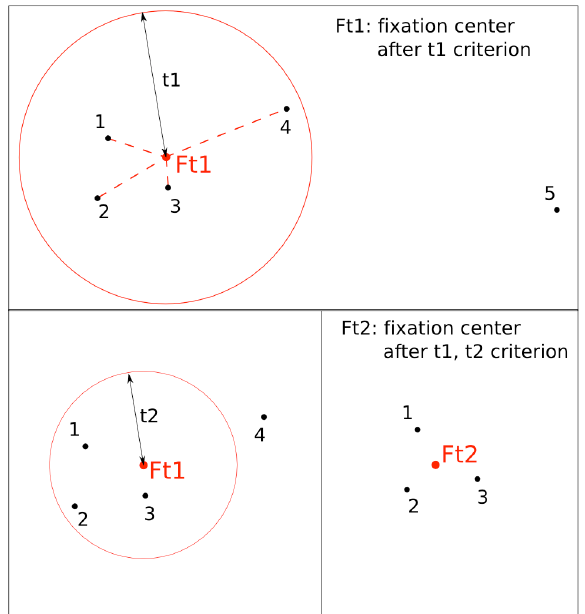
The application of the spatial parameters (t1, t2) for the per- formance of fixation detection algorithm in the eye tracking protocol consisted of the points (1, 2, 3, 4 and 5). Ft2 corre- sponds to the center of fixation cluster after the application of the two spatial